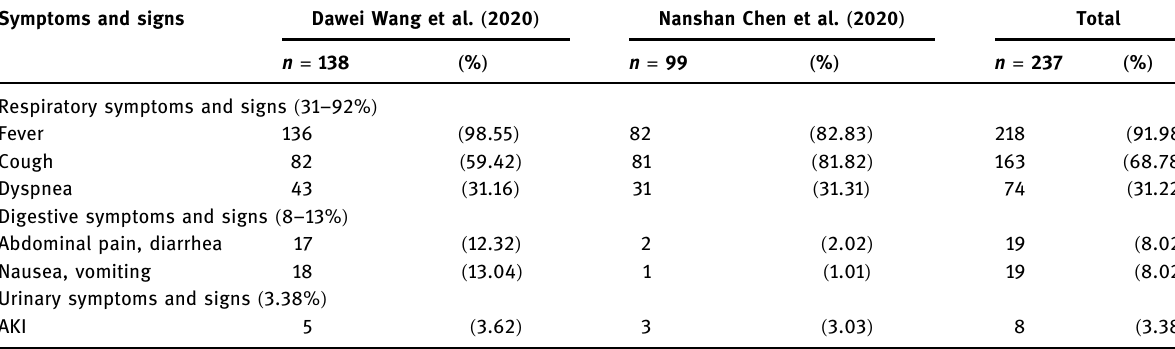
Table 2: Representative three - system related symptoms of COVID - 19 patients infected with SARS - CoV - 2 Symptoms and